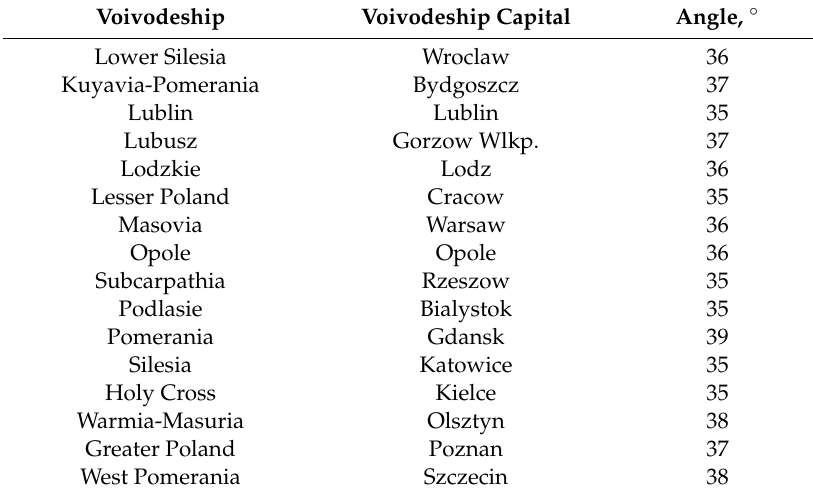
Table 1. The juxtaposition of optimal installation angels for solar installation